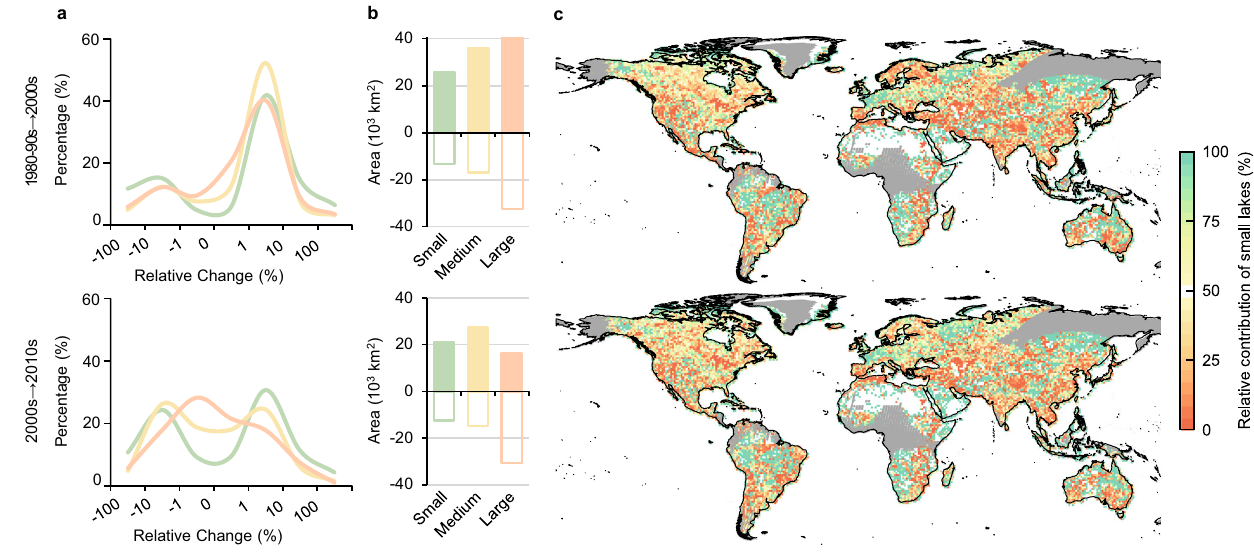
Fig.3|Outsizedroleofsmalllakes.a Histogramsofrelativearealchangesderived for global lakes partitioned into different size groups between given time periods. b Absolute areal changes in lakes within different size groups between time peri- ods,includingbothpositiveandnegativechanges. c Relativecontributionsofsmall